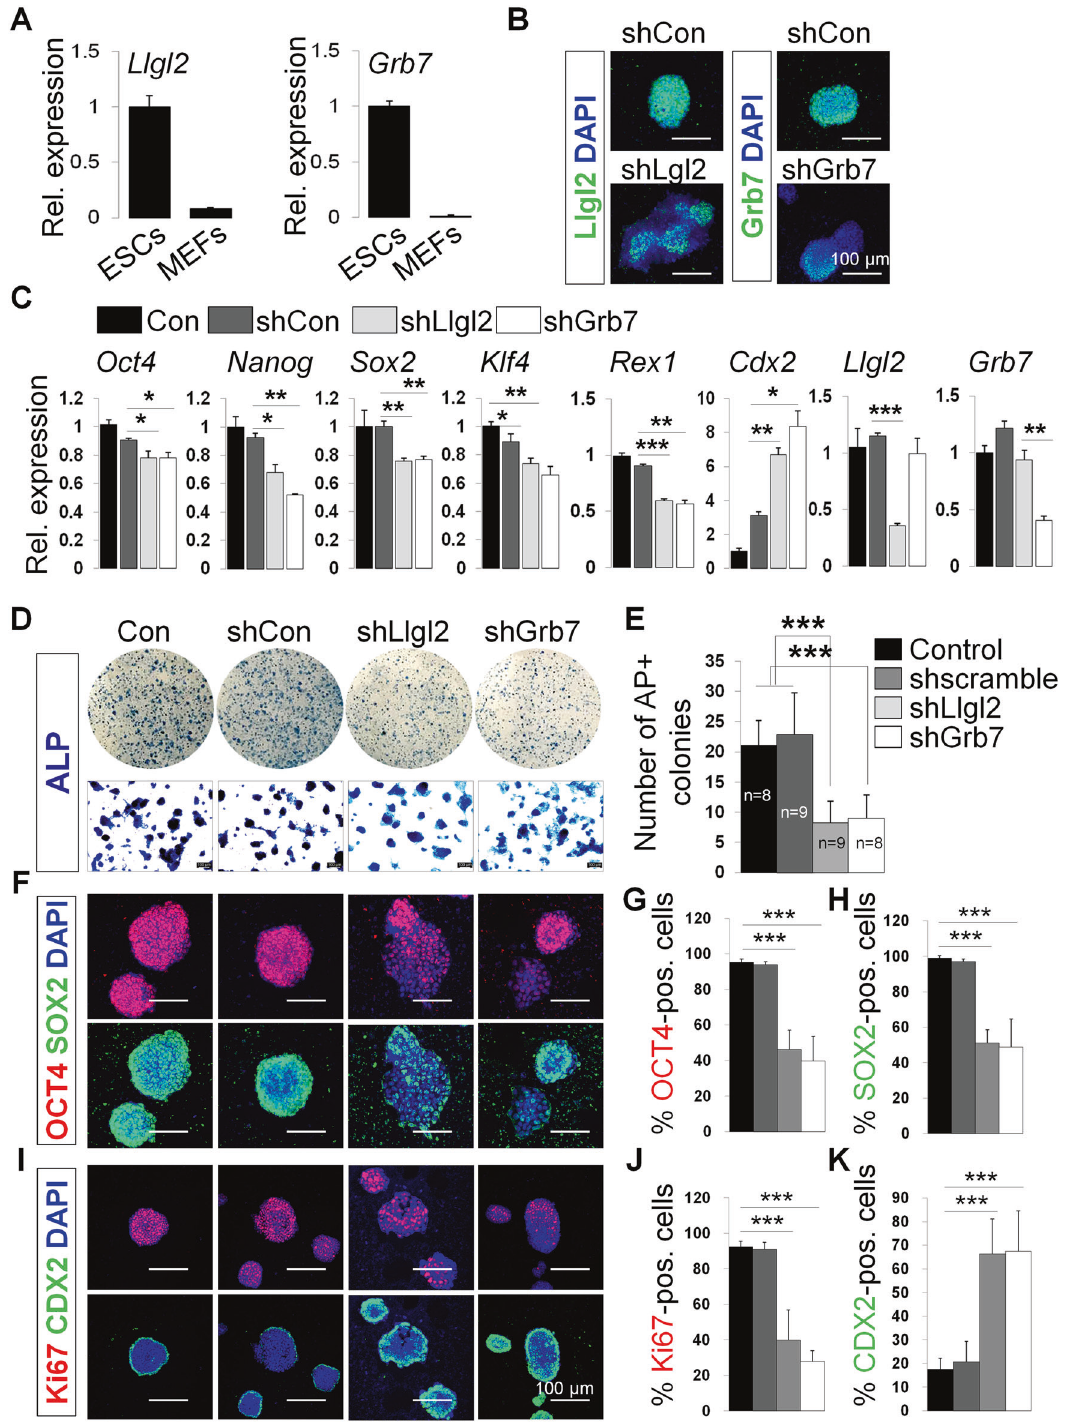
Fig. 4 Knock down of Llgl2 and Grb7 abrogates mESC pluripotency. A qPCR on ESCs and MEFs for endogenous Llgl2 and Grb7 expression; B Representative images of Llgl2 and Grb7 immuno fl uorescence in ESCs after knocking down by shRNAs; C qPCR measuring pluripotency gene ( Oct4 , Nanog , Sox2 , Klf4 , Rex1 ) expression after knocking down Llgl2 and Grb7 compared to control knock down and wild-type E14 ESCs. Cdx2, a marker for trophectoderm, is also shown; D AP + staining ESC colonies after knocking down by shRNAs for Llgl2 or Grb7 or control compared with wildtype E14 control colonies. E Quanti fi cation of AP + staining ESC colonies per area (mm 2 ); F Immuno fl uorescence staining of OCT4 and Sox2 in shRNA knock down cells; G , H Quanti fi cation of positive immuno fl uorescent knock down cells for Oct4 and Sox2 expression; I Immuno fl uorescence staining of Cdx2 and Ki67 in shRNA knock down cells; J , K Quanti fi cation of positive immuno fl uorescent knock down cells for Cdx2 and Ki67 expression. In panels A , data were compared by unpaired t tests (*** p < 0.0001). In panels B , F , I , representative images shown at a 100 μ m scale. In panel D , representative images are shown at 40X scale. In panels E , G , H , J , K , data plotted are mean ± SD for triplicate samples and were compared by one-way ANOVA with Tukey ’ s post hoc test. (* p < 0.01, ** p < 0.001, *** p <